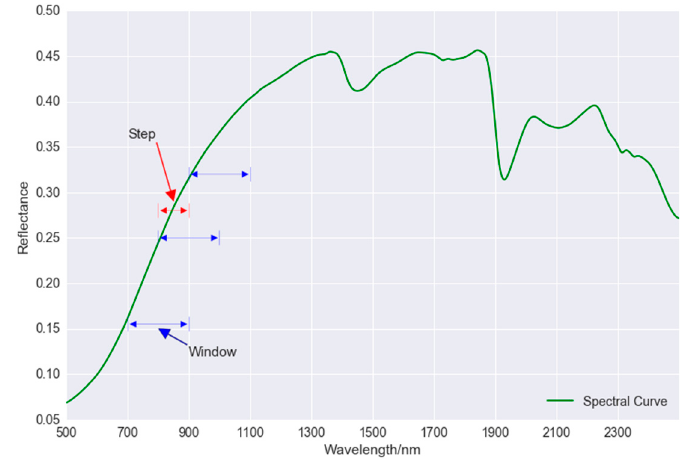
Figure 3. Illustration of the meaning of step and window size for multiple fractal feature generation. (step size = 100.0 nm, window size = 200.0 nm).